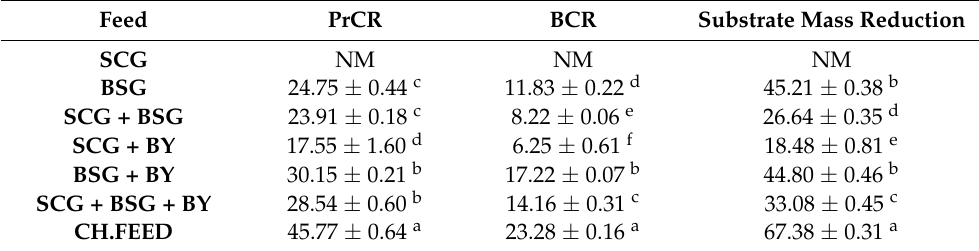
Table 4. Protein conversion rate, bioconversion rate and mass reduction after feeding with tested diets (mean ± standard error n = 4). Mean values followed by different letter in the same column vary significantly ( p < 0.05). NM: Not